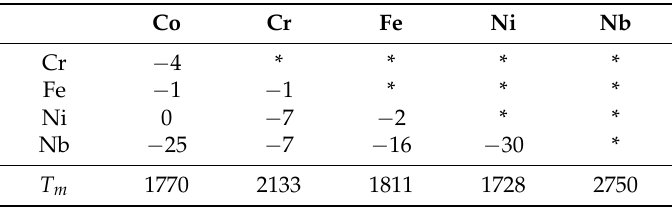
Table 3. Mixing enthalpy ( ∆ H mix , kJ/mol) values of atom pairs and melting temperature of